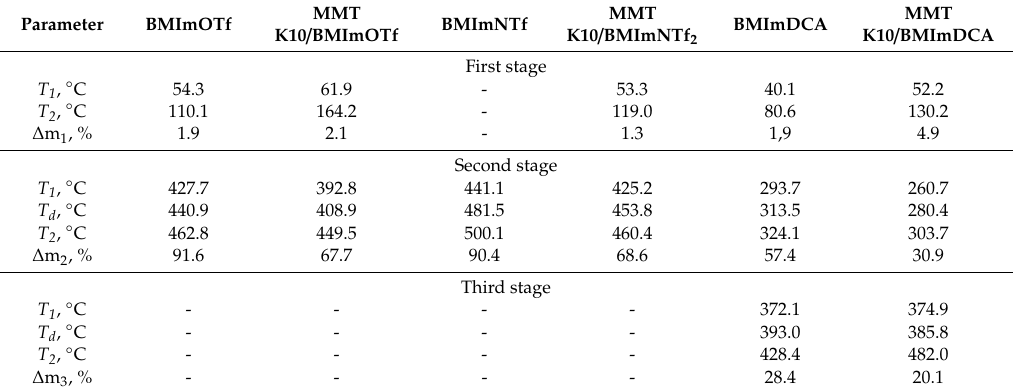
Table 3. Characteristic temperatures ( T ) and mass loss ( ∆ m i ) of the thermal decomposition of the samples under